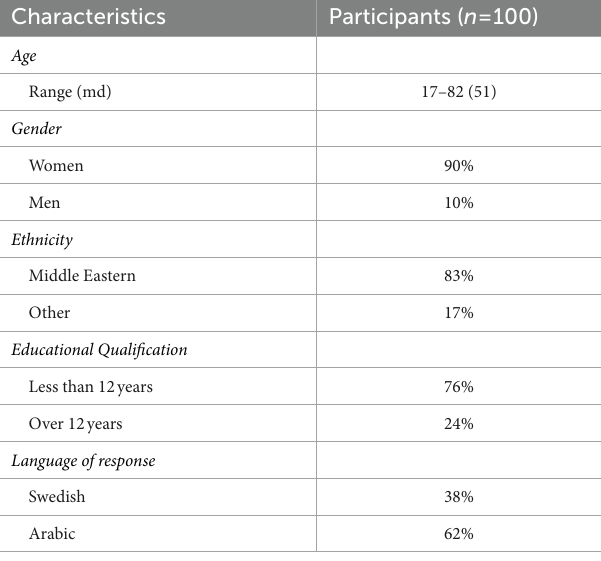
TABLE 2 Demographic characteristics of participants in this